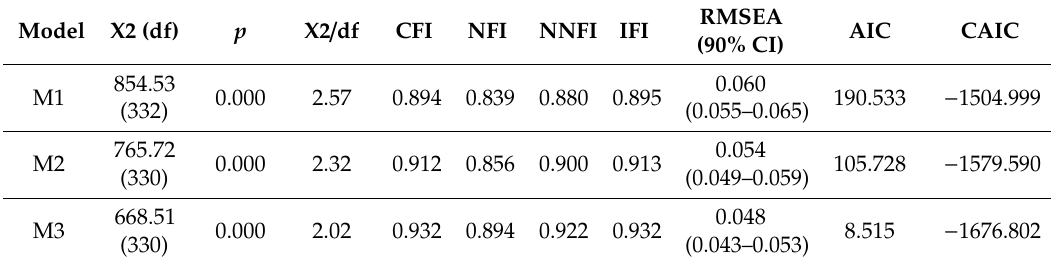
Table 1. Goodness-of-fit indicators for the hypothesized theoretical